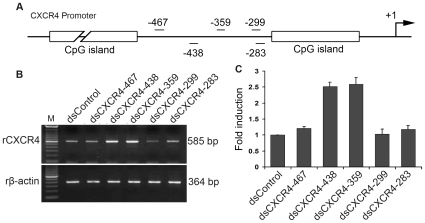
RNAa-mediated induction of CXCR4 in primary rat stem cells.
A. A schematic representation of the rat CXCR4 promoter. Indicated are the CpG islands, transcription start site (+1), and locations of the target sites corresponding to each of the five putative saRNAs. B. Each saRNA was transfected at 50 nM concentrations into rADSCs for 4 days. CXCR4 and β-actin mRNA expression levels were assessed by standard RT-PCR. β-actin served as a loading control. C. Expression of CXCR4 was quantified by densitometry and adjusted to β-actin levels. Results are mean ± SEM of 3 independent experiments.